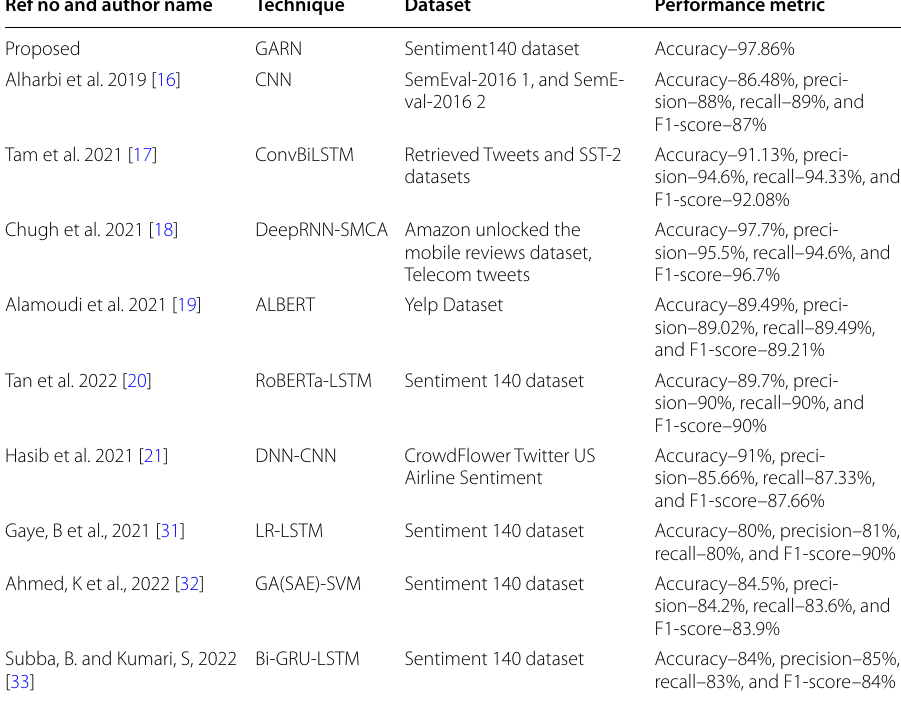
Table 9 Performance comparison between developed existing and proposed